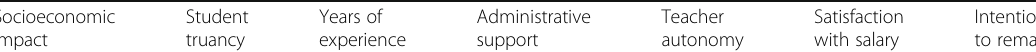
Table 2 Pattern coefficients for the measurement